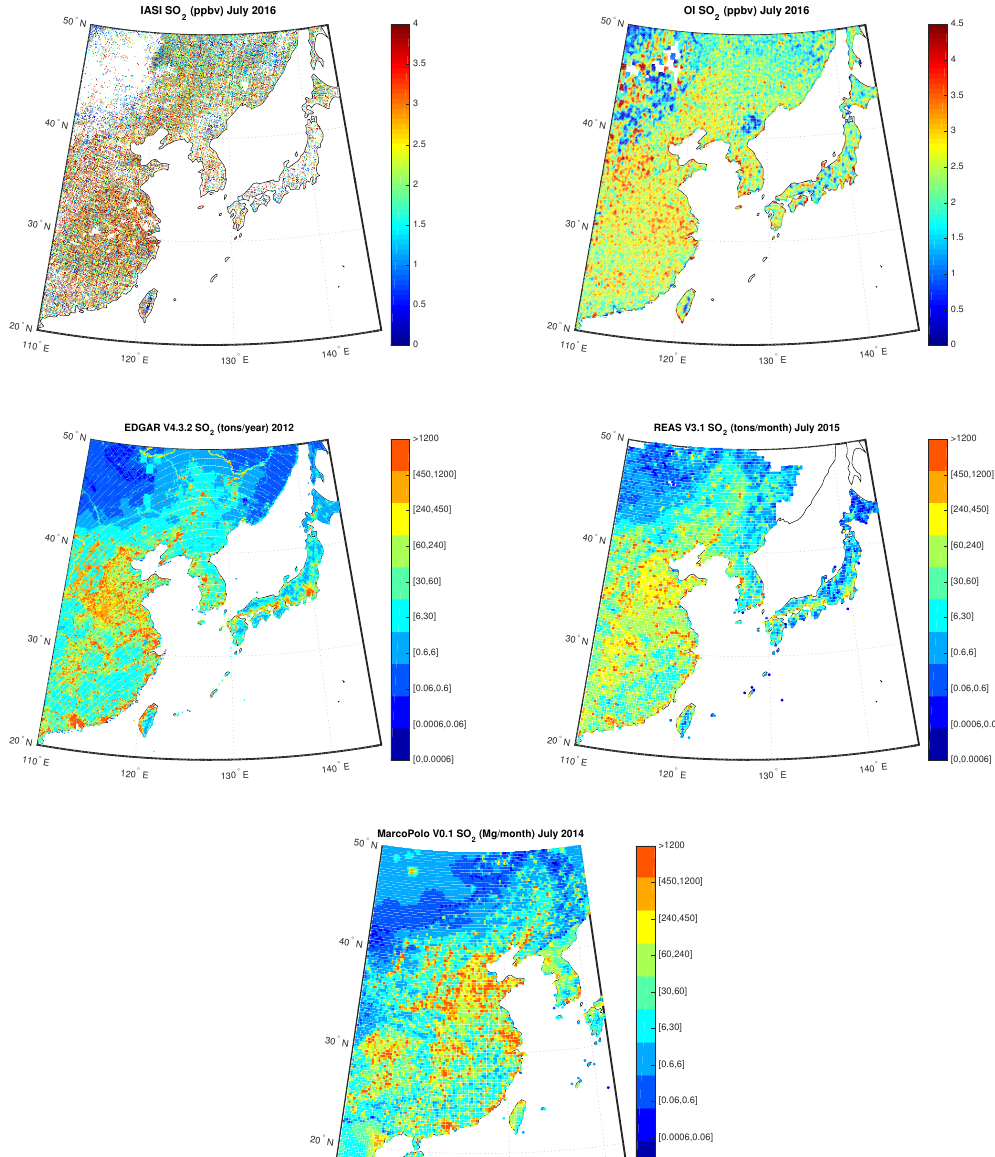
Figure 16. First row: IASI and OI SO 2 over China for the month July 2016; Second Row: EDGAR V4.3.2 SO 2 for the year 2012 and REAS V3.1 SO 2 for the month of July 2015; Third Row: MarcoPolo v0.1 SO 2 for the month of July